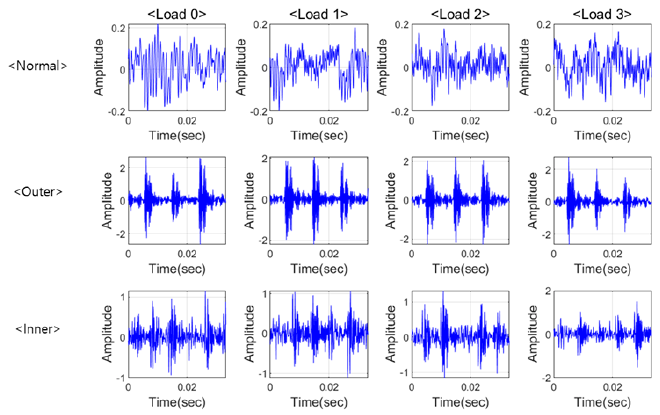
Figure 4. CWRU data in time domain.